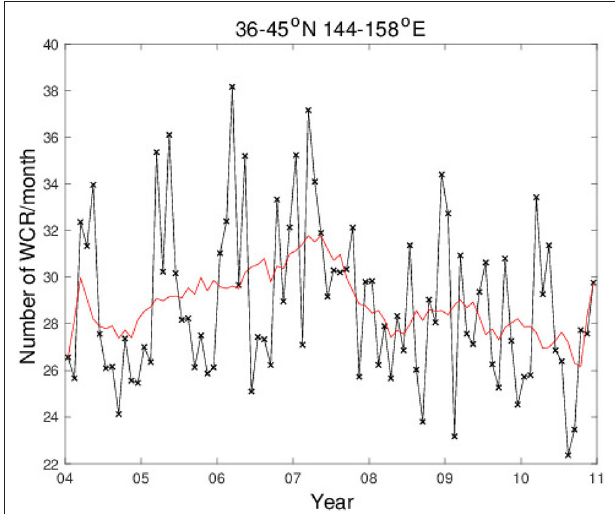
FIGURE 12 | Temporal variation of number of detected warm-core eddies per month, from 2004 through 2010 in the western North Pacific region 144–158 ◦ E and 36–45 ◦ N, is represented by black cross and line. The red curve shows moving average with a period of a